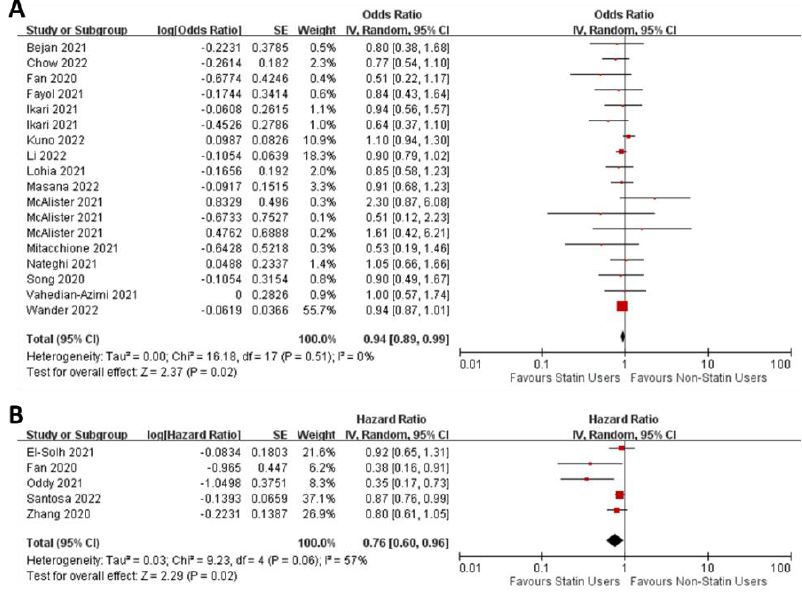
Figure 3. Forest plots of adjusted odds ratio ( A ) and hazard ratio ( B ) for ICU admission in statin users versus non-users among COVID-19 patients.